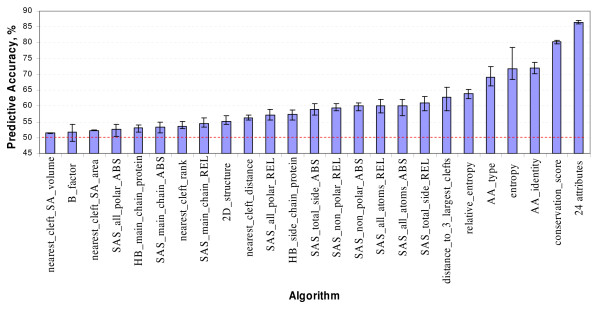
The predictive accuracy of the SMO algorithm based on individual residue properties in comparison with 24 combined attributes.